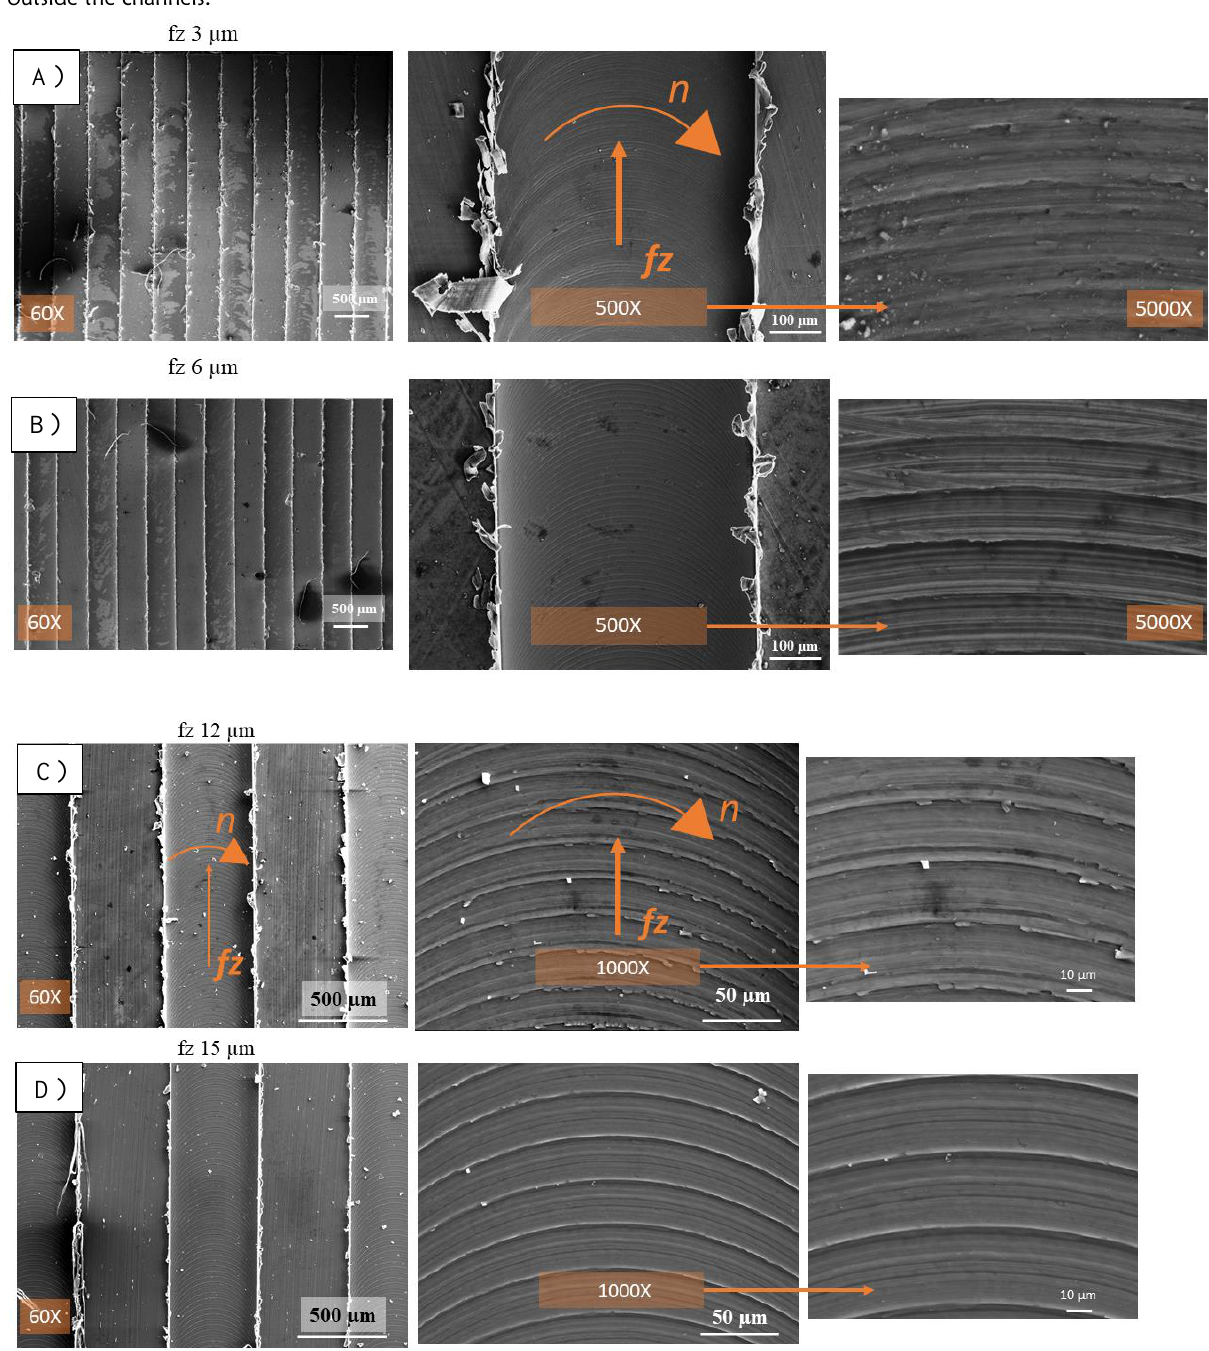
Figure 4: Scanning electron microscopy fz = 3, 6, 12 and 15 µm. A) Severe burr formation for fz = 3 µm. B) Lower burr formation for fz = 6 µm. C) Lower burrs pushed outside of the channels for fz = 12 µ m. D) Lower burrs and pronounced feed marks for fz = 15